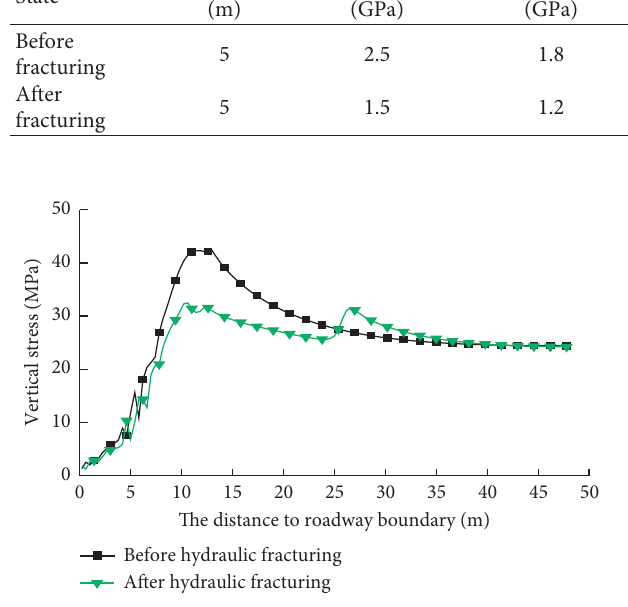
Figure 11: Vertical stress redistribution of roadway sidewall before and after hydraulic fracturing.